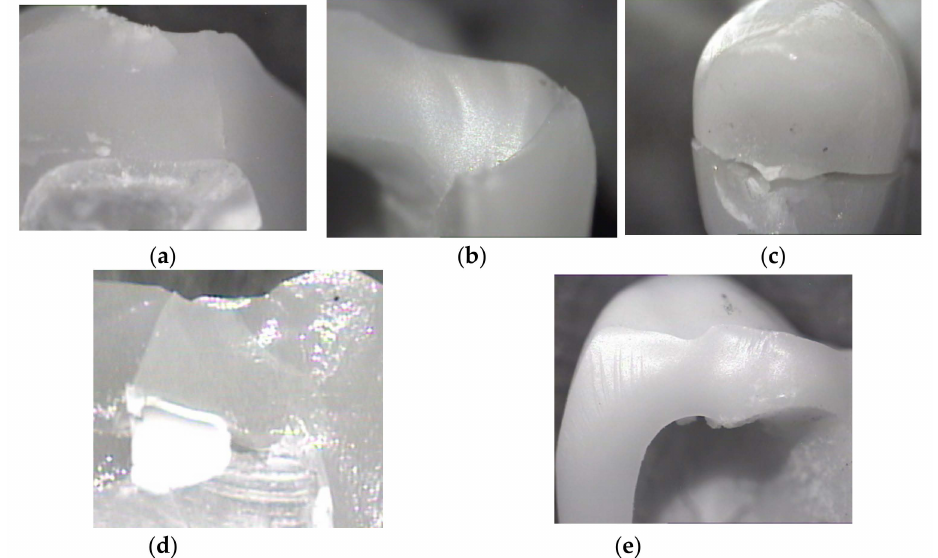
Figure 4. Stereomicroscope images: ( a ) of an occlusal marginal edge of one half of a ZLSP crown, is a clinical view with the origin of the fracture with a hackle and an arrest line. ( b ) Of a distal marginal edge chip of FM crown with the fracture origin and edge chips. ( c ) ZLSM crown split vertically into two halves. ( d ) One half of FP crown with two different directions of crack propagation ( e ) ZLSM and the origin was an edge chip from a force applied on the bottom of the margin aimed upwards, multiple hackles (twit hackles) can be observed as